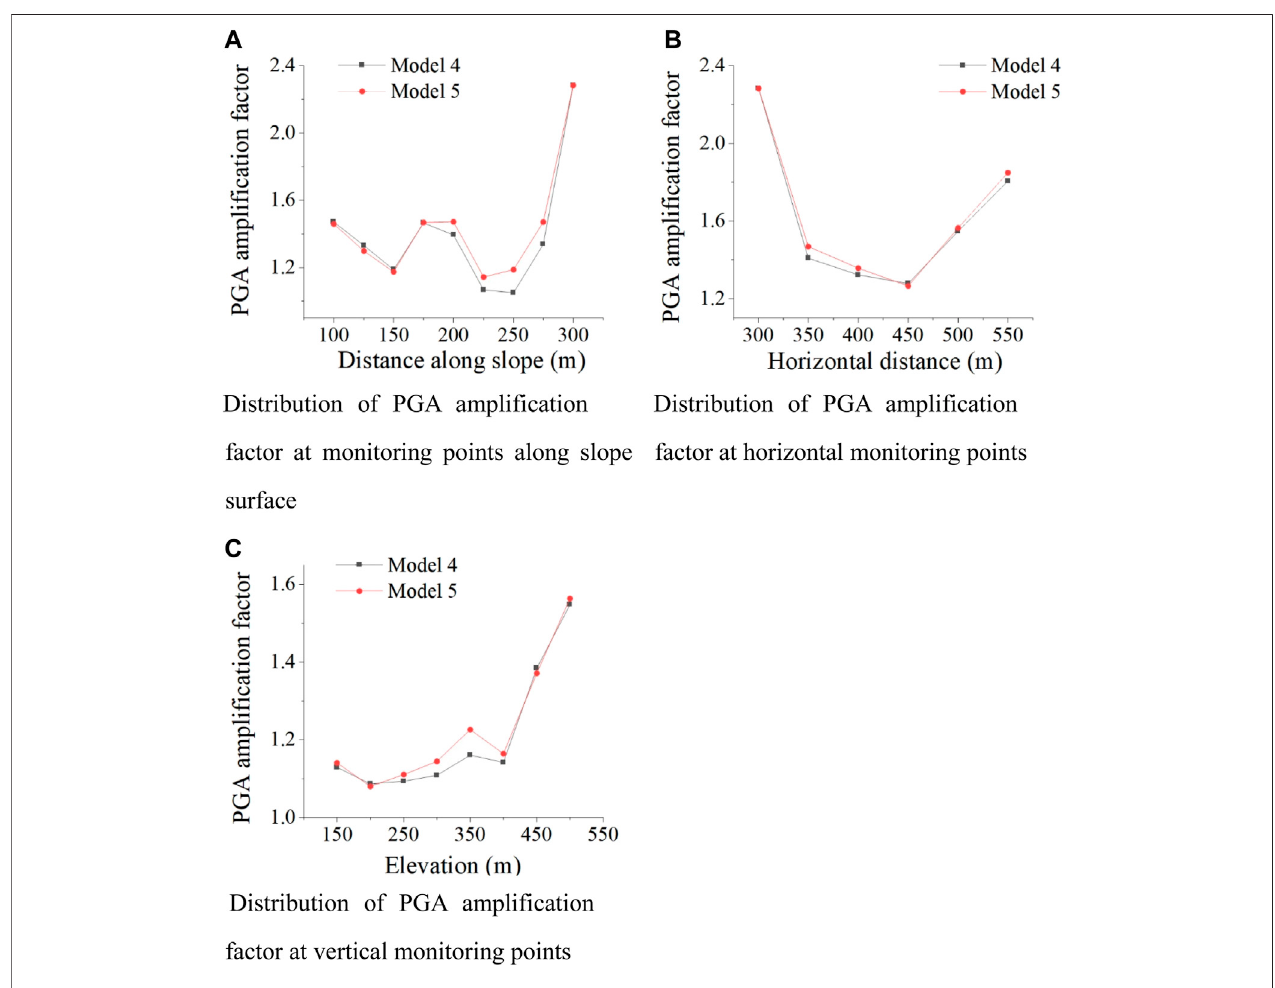
FIGURE 7 | PGA ampli fi cation factor of the monitoring points of slope. (A) Distribution of the PGA ampli fi cation factor at monitoring points along the slope surface. (B) Distribution of the PGA ampli fi cation factor at horizontal monitoring points. (C) Distribution of the PGA ampli fi cation factor at vertical monitoring points.